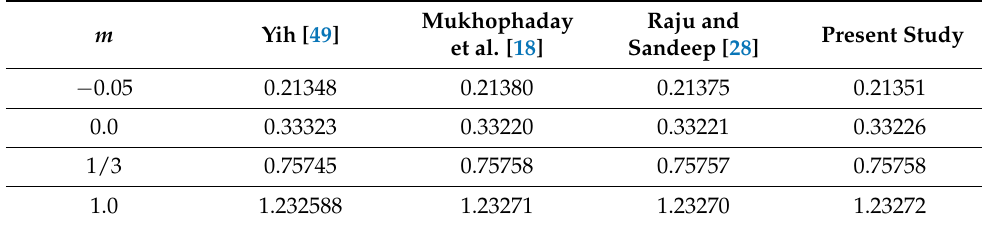
Table 2. Comparison of the skin friction coefficient ( f (cid:48)(cid:48) ( 0 ) ) for different values of m